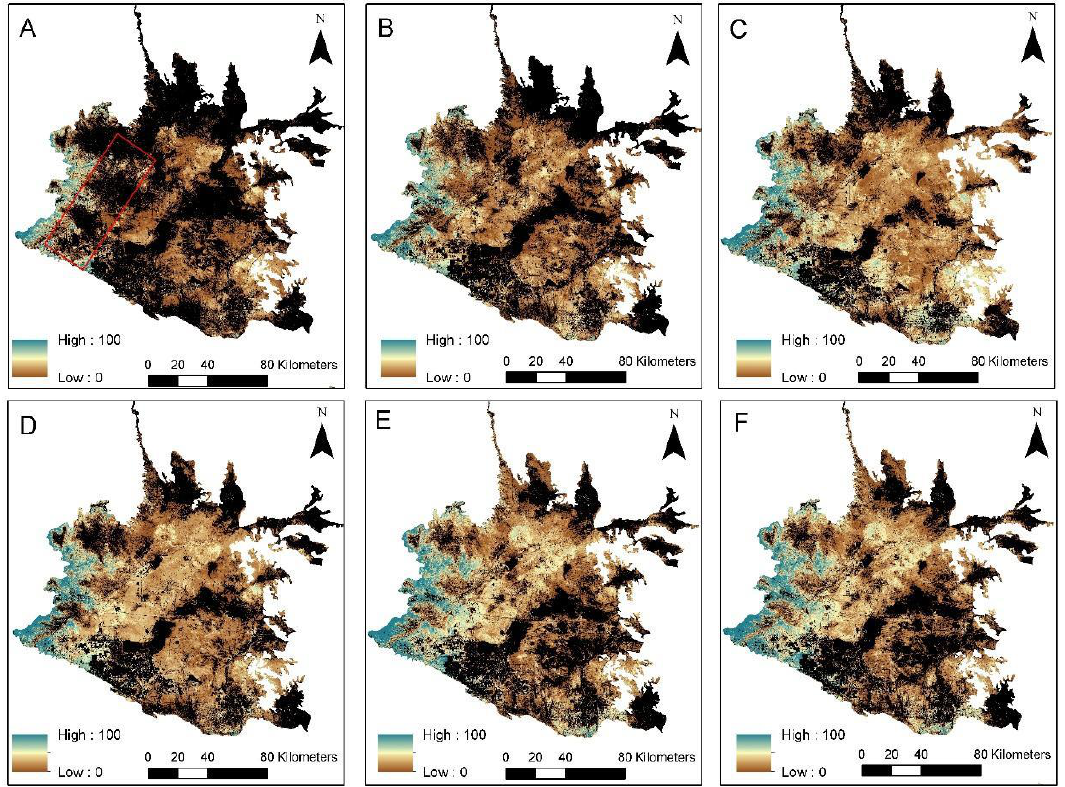
Figure 7. 5-year average ESI values across the Western Mojave Basin ecoregion. Red box in panel A Figure 7. Five-year average ESI index values across the Western Mojave Basin Ecoregion for six outlines the wind energy areas. Blue values indicate persistent yearly high ( > 0.2, summed for the periods: ( a ) 1989 – 1993, ( b ) 1994 – 1998, ( c ) 1999 – 2003, ( d ) 2004 – 2008, ( e ) 2009 – 2013, and ( f ) 2014 – 2018. period) values over each period. Periods are ( A ) 1989–1993, ( B ) 1994–1998, ( C ) 1999–2003, ( D ) 2004–2008, The red box in (A) outlines the wind energy areas. Blue values indicate persistent yearly high (>0.2, ( E ) 2009–2013, and ( F ) summed for the period) values over each period.